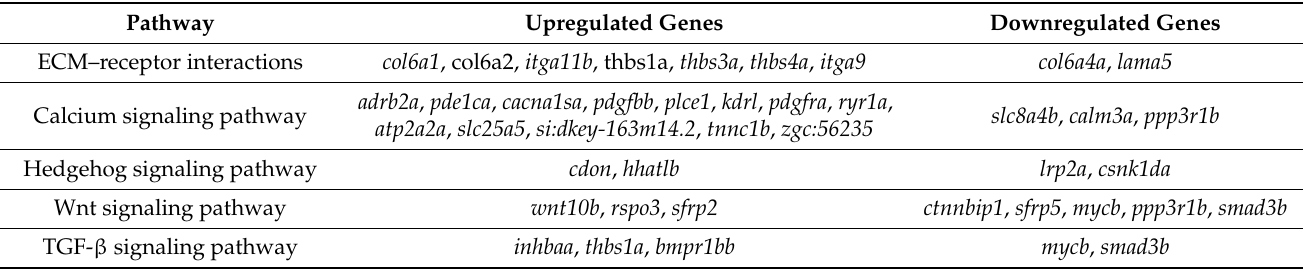
Table 1. The DEmRNAs in known pathways associated with bone